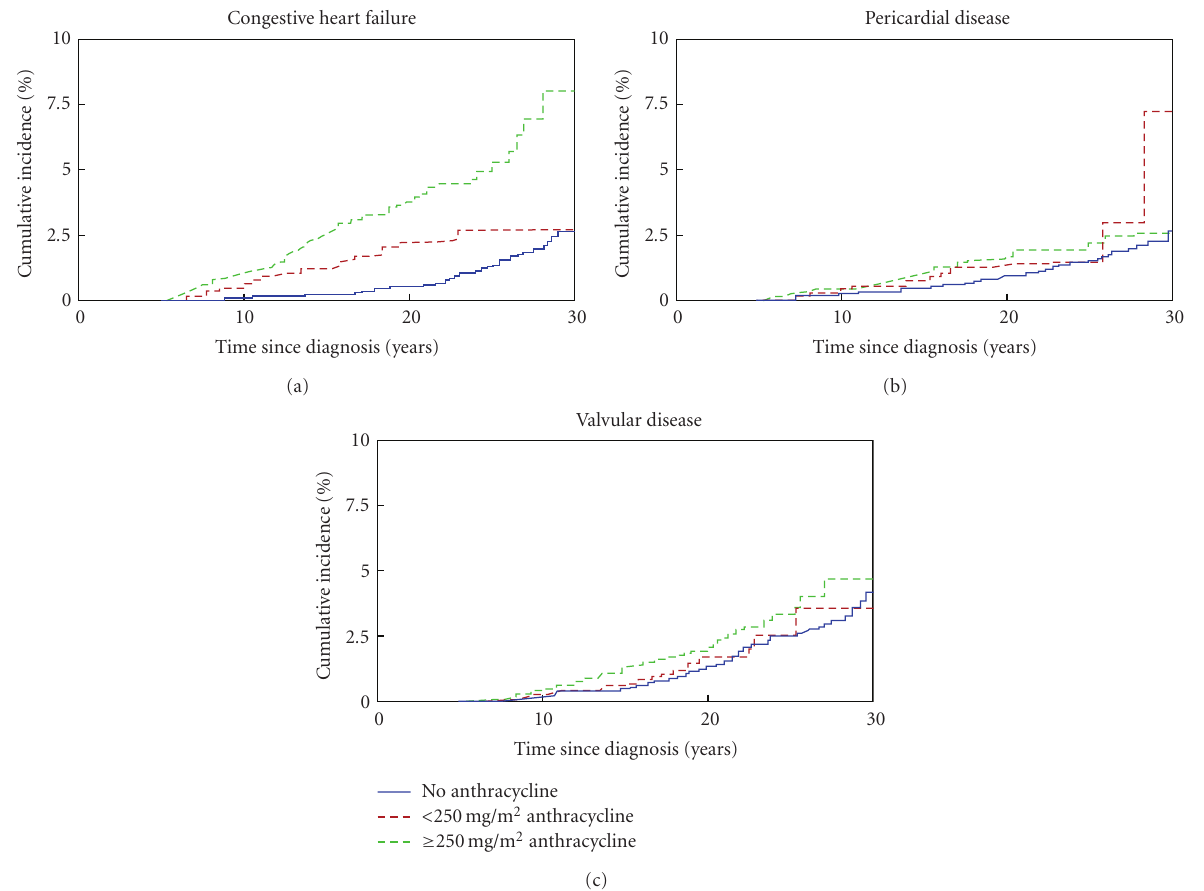
Figure 1: Cumulative incidence of cardiac disorders among childhood cancer survivors by anthracycline dose. From Mulrooney et al. [7]. Reprinted with permission from BMJ Publishing Group,